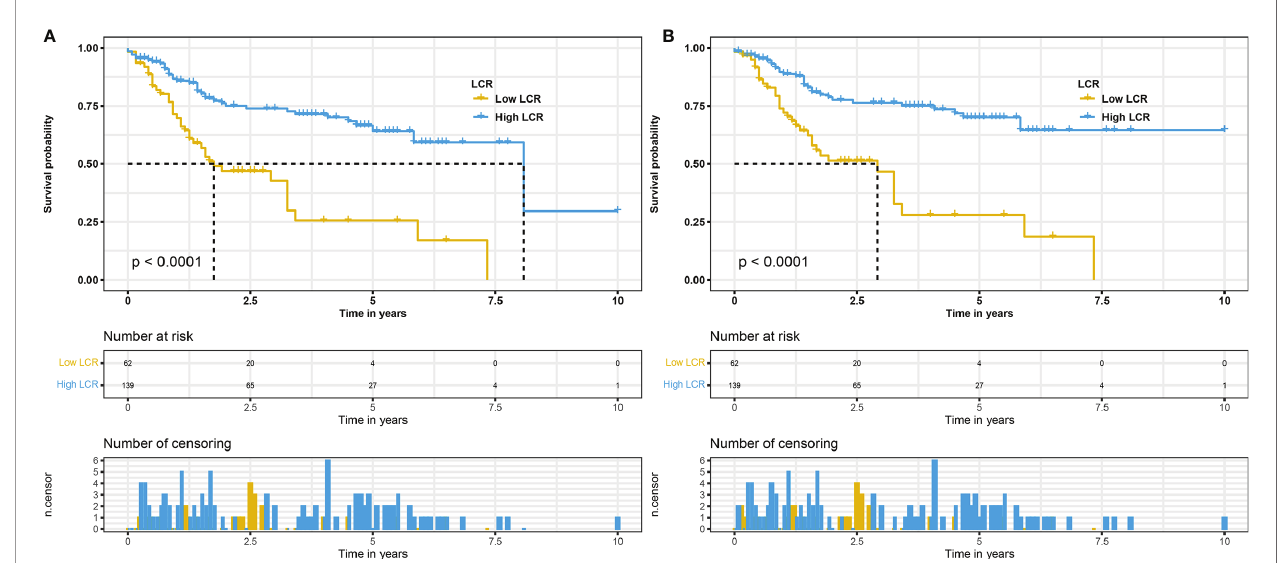
FIGURE 1 | Kaplan – Meier curves for OS in patients with radical cystectomy strati fi ed based on LCR before propensity score matching (A) . Kaplan – Meier curves for DFS in patients with radical cystectomy strati fi ed based on LCR before propensity score matching (B) . OS, overall survival; LCR, lymphocyte – C-reactive protein ratio; DFS, disease-free